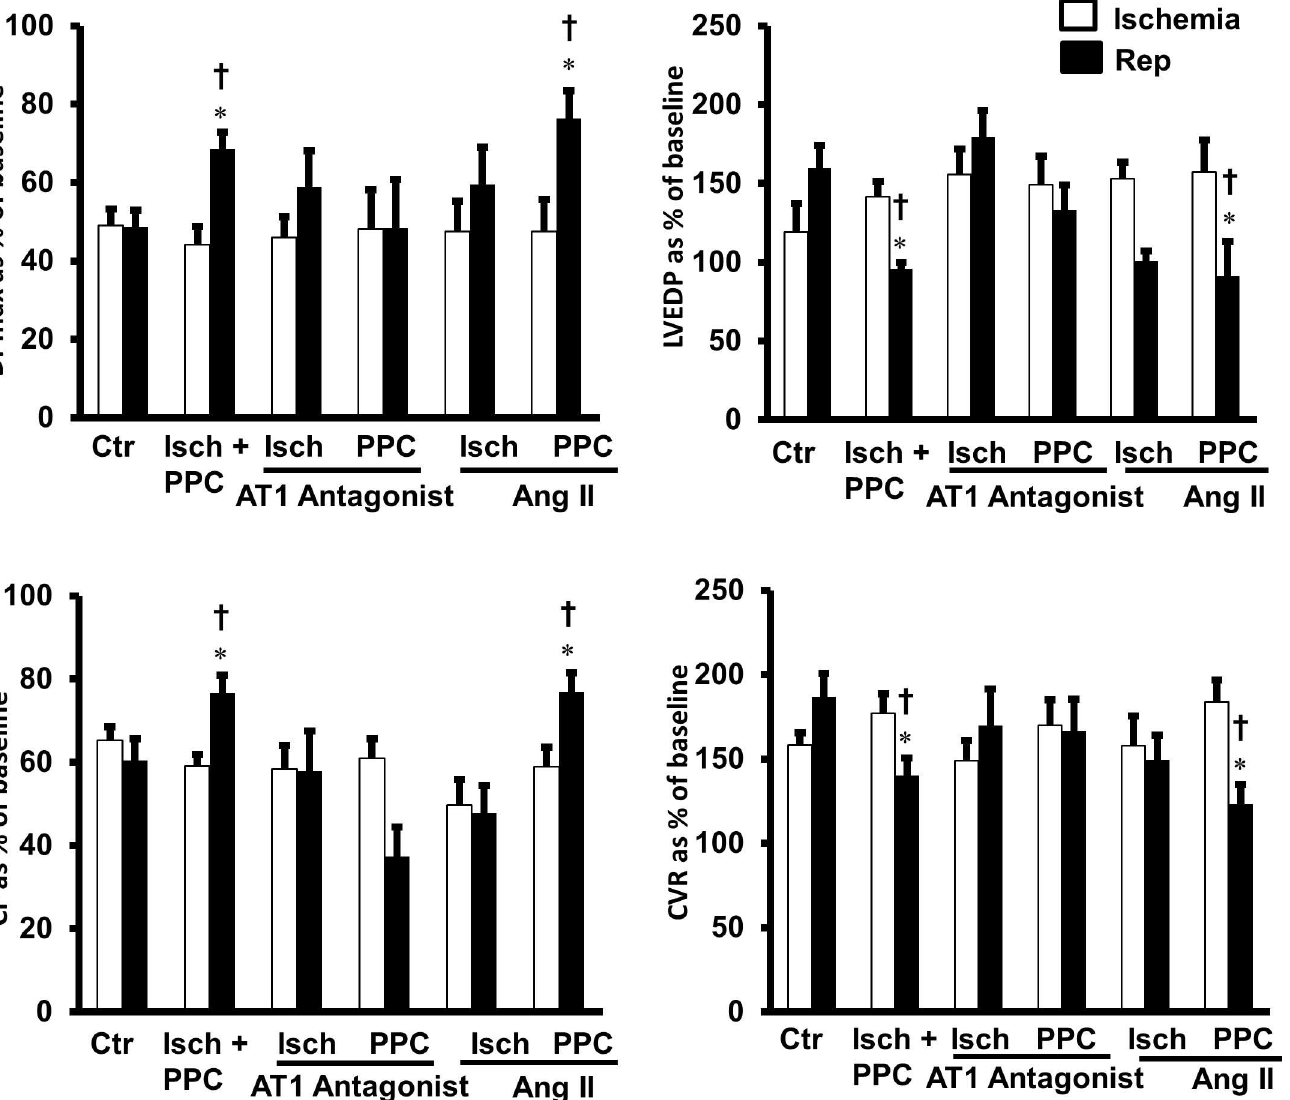
Fig 2. The role of exogenously administered Ang II and Ang II receptor, AT1, in PPC. Isolated rat heart (n = 8 per group) were subjectedto I/R injury with or without PPC. Hearts were then infused with Ang II (100nM) or AT1 antagonist (irbesartan,10 μ M) and post-ischemic recovery of cardiac functions were recorded. (A) DPmax, (B): LVEDP, (C) CF and (D) CVR. The data were computed at 30 min reperfusionand are expressed as means ± SEM. DPmax, maximum developed pressure; LVEDP, left ventricular end diastolicpressure; CF, coronary flow; CVR, coronary vascular resistance; Ctr, control; Isch, ischemia; PPC, pacing postconditioning. * P < 0.05 comparedto respective control. † P < 0.05 compared to ischemic period.